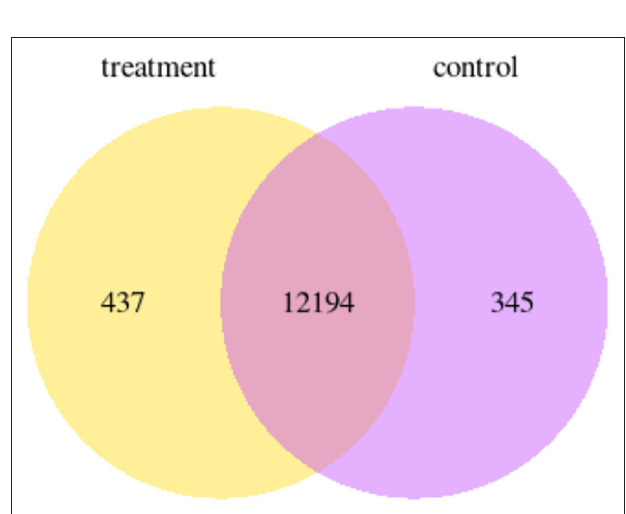
FIGURE 4 | Venn diagram showing the number of genes that are uniquely expressed within each group yellow = ELA mice, purple = weight-matched